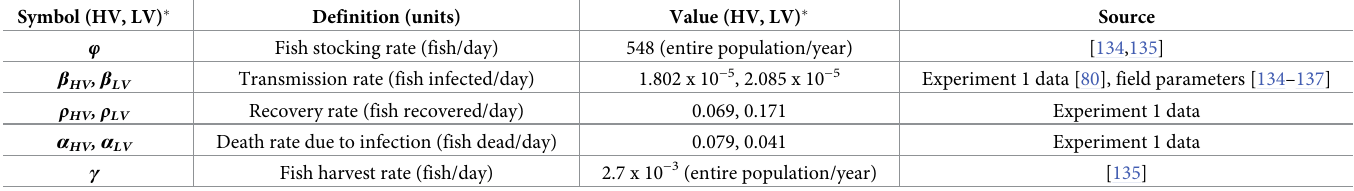
� Symbols and values are given for IHNV genotypes ( g ) HV and LV respectively. If single value given, same for both